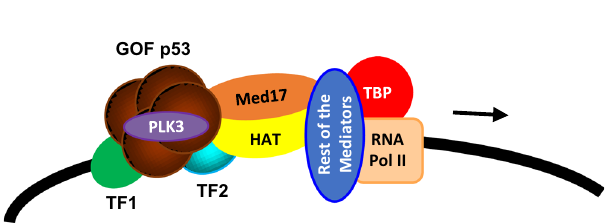
Fig. 9 Proposed model for GOF p53 nucleating on an inducible promoter. Arrow toward the right-hand side depicts transcription direction. For simplicity TAF and other factors are not